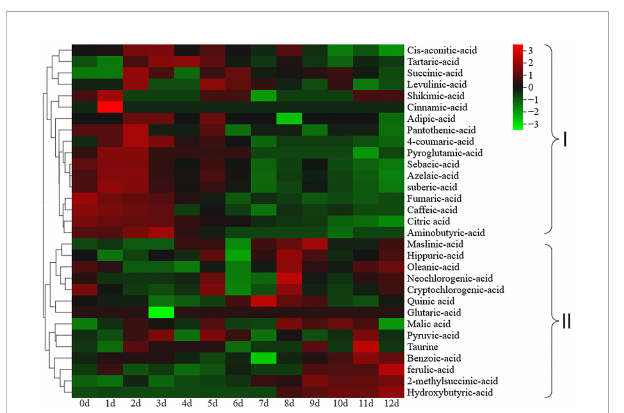
FIGURE 3 Cluster heatmap analysis based on the energy metabolite accumulation levels at different ripening stages. Organic acids in clade I and clade II gradually decreased and increased during ripening,